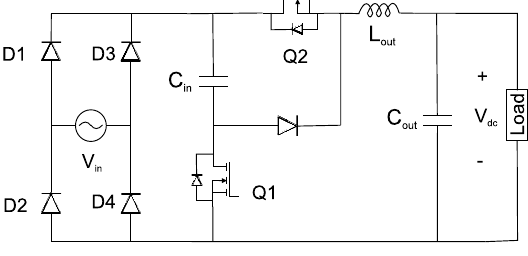
Figure 12. Configuration proposed in